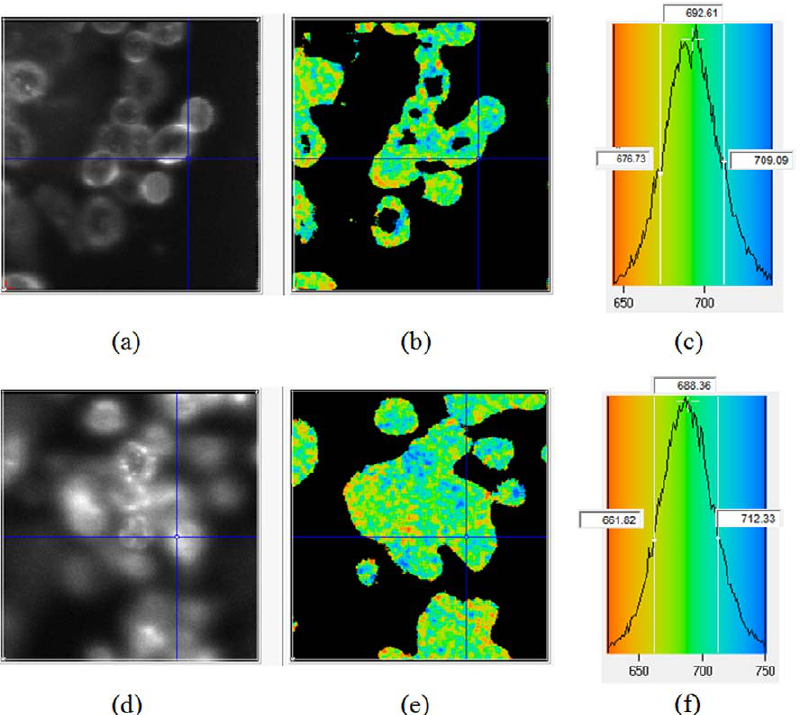
Figure 11. In-vitro image of HER2 positive cancer cells (SKBR3) exposed to HER2-Affibody-Dylight750 in (A–C) PBS and (D–F) cell culture with 10% FBS. Figures ( A ) and ( D ) show the intensity and ( B ) and ( E ) show the lifetime image. The histogram of the lifetime distribution has been shown in figures ( C ) and ( F ) for PBS and 10% FBS in cell culture media, respectively.